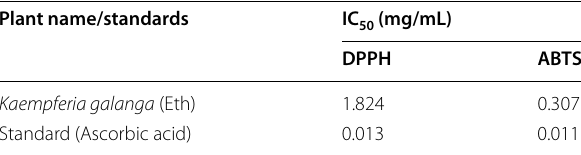
Table 3 IC value of DPPH and ABTS of the ethanolic extracts of 50 K.